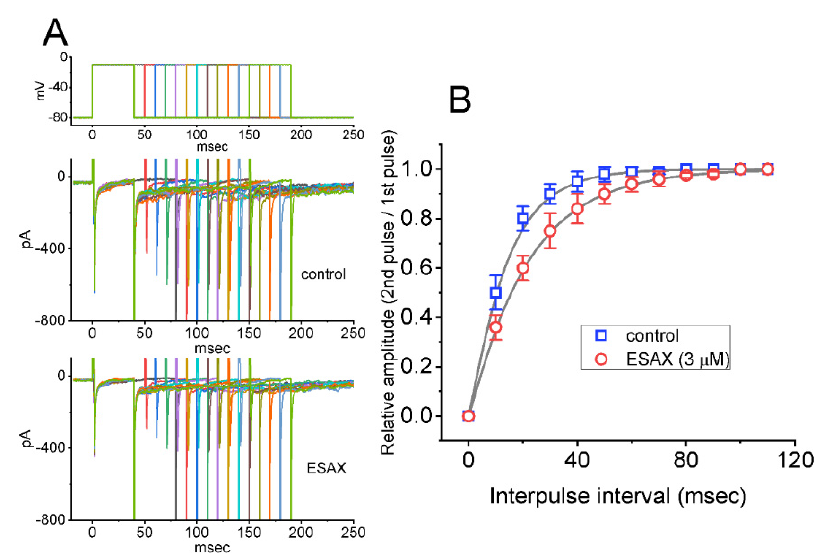
Figure 3. ESAX-induced prolongation in the recovery of I Na block in GH 3 cells. Cells were bathed in Ca 2+ -free, Tyrode’s solution, the electrode was filled with Cs + -containing solution, and a set of two-pulse voltage protocol was applied to the examined cells. ( A ) Representative current traces showing current recovery from block by use of two-step protocol with varying durations (as indicated in the uppermost part). Current traces in the upper part were obtained in the control period, while those in the lower part were taken during cell exposure to 3 µ M ESAX. ( B ) Relationship of relative amplitude versus interpulse interval in the absence ( □ ) and presence ( ○ ) of 3 μ M ESAX. The relative amplitude of peak I Na was taken by the ratio of current amplitudes elicited by the second depolarizing voltage step and those by the first pulse. Each point represents the mean ± SEM ( n = 8). The smooth line indicates a best fit to single exponential.